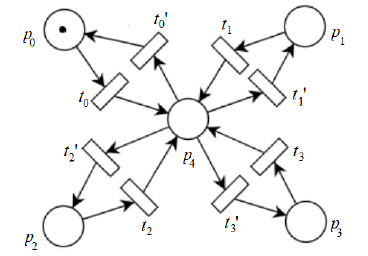
Figure 13. QPN model of oriented QDRW on a sphere.